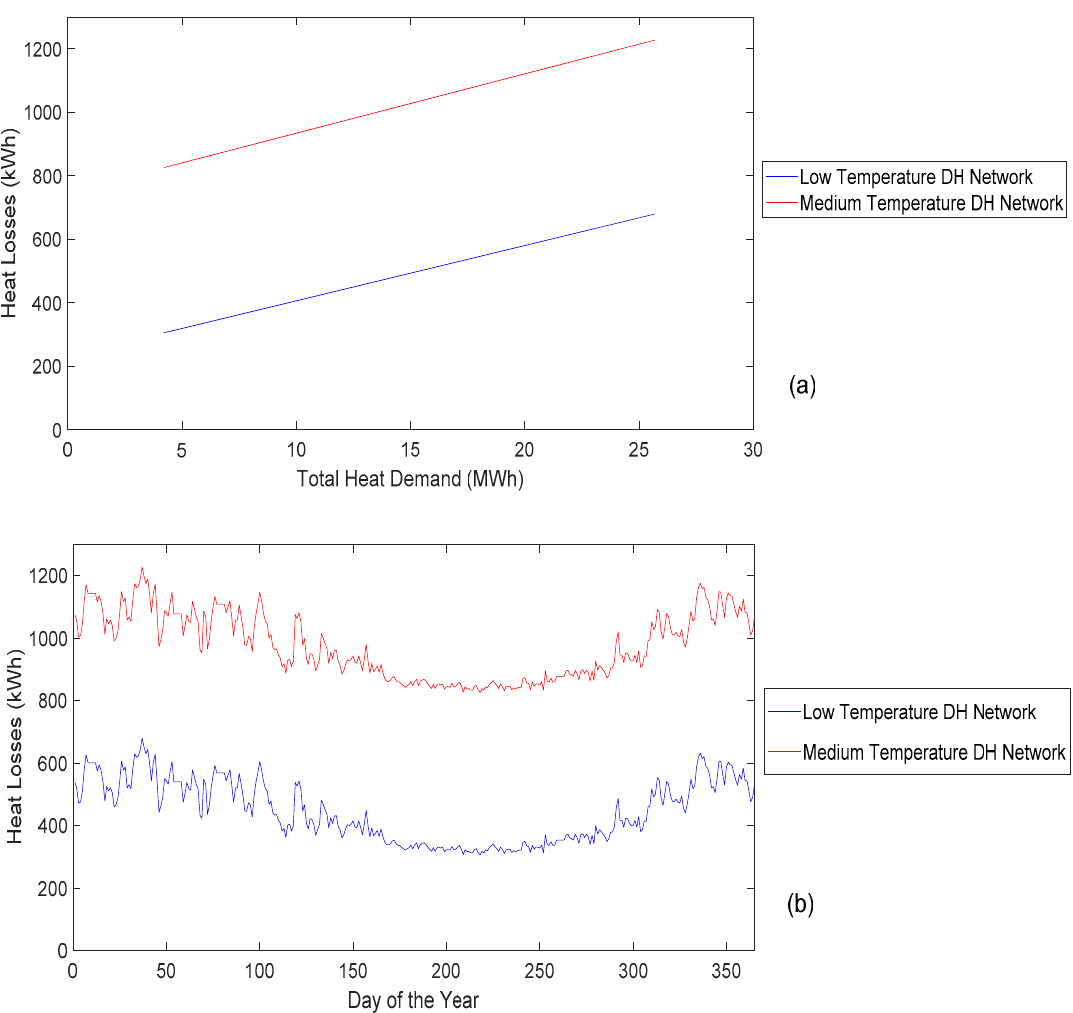
Figure 7. ( a ) Distribution heat losses for medium and low temperature DH networks as function of thermal demand, ( b ) Distribution thermal losses in the medium and low temperature DH networks along the year.